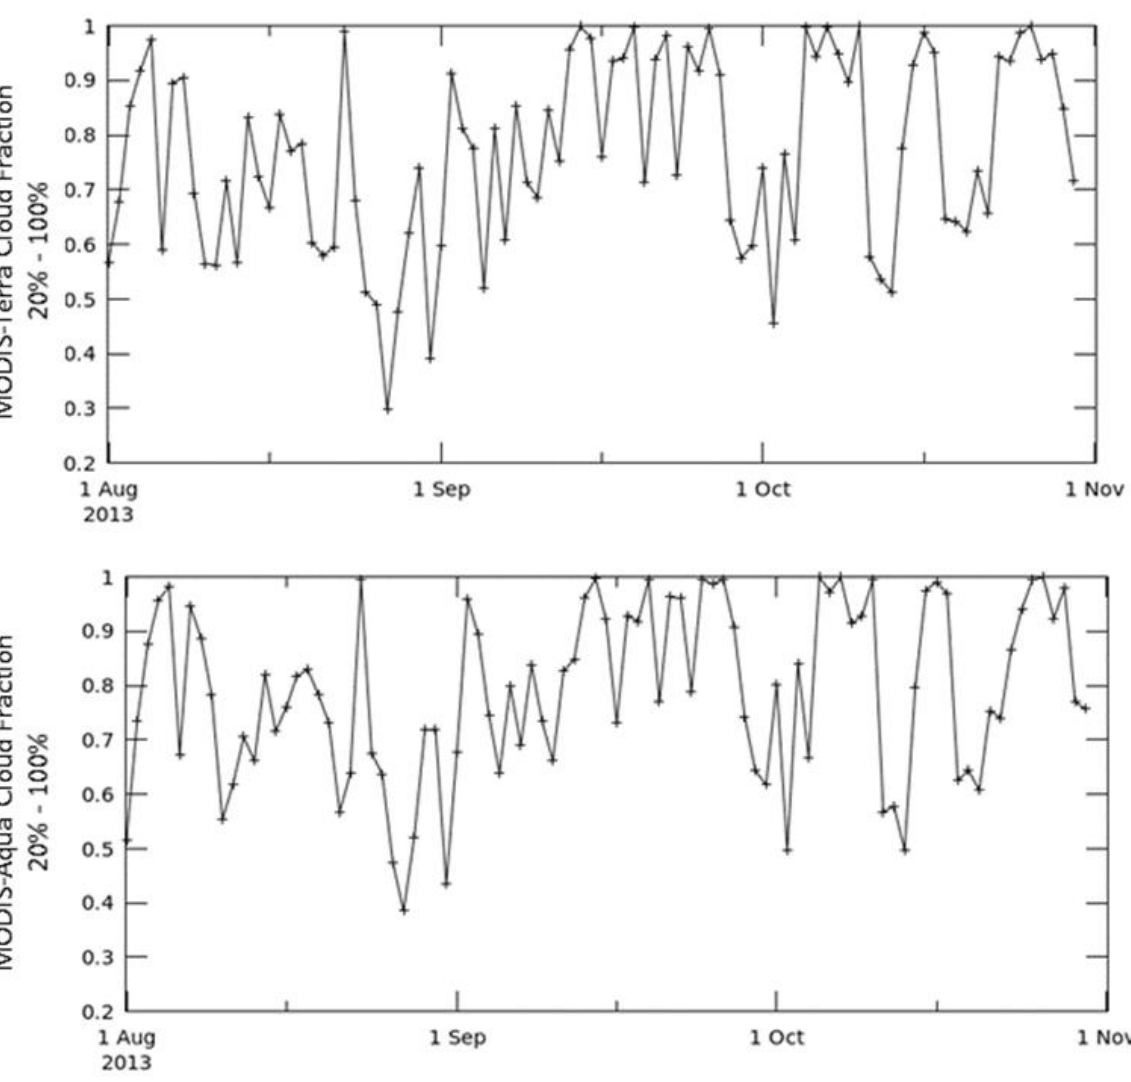
Figure 15 . Time series of (top) MODIS-Terra and (bottom) MODIS-Aqua daily daytime cloud frac- Figure 15. Time series of ( top ) MODIS-Terra and ( bottom ) MODIS-Aqua daily daytime cloud fraction tion for the period August – September 2013 for the region 145 – 160E, 5 – 10 N. for the period August–September 2013 for the region 145–160 ◦ E, 5–10 ◦